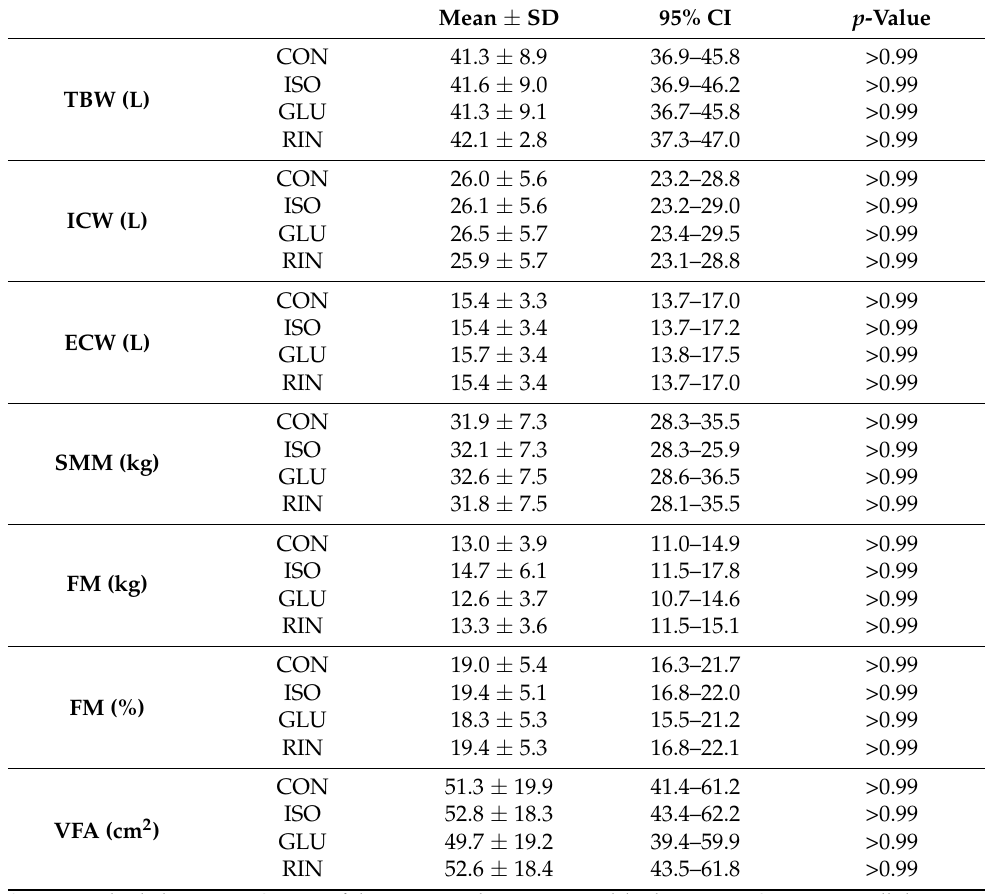
Table 2. Baseline values (t rest ) of body composition on the four trial-related visits. Mean ±